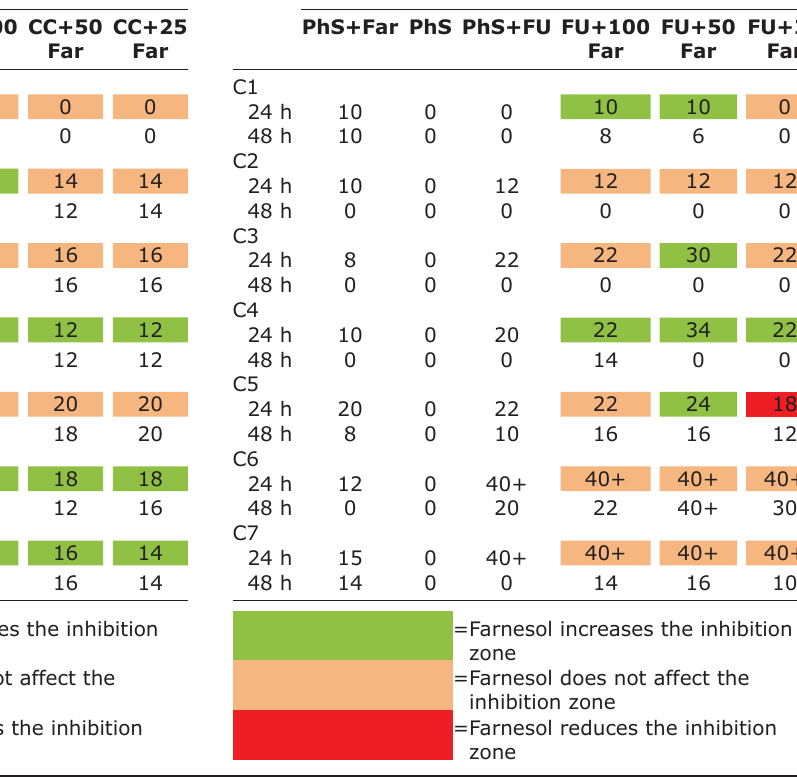
Table-4: Clotrimazole sensitivity determination of 7 Candida albicans strains and the effect of farnesol three concentrations on these results.